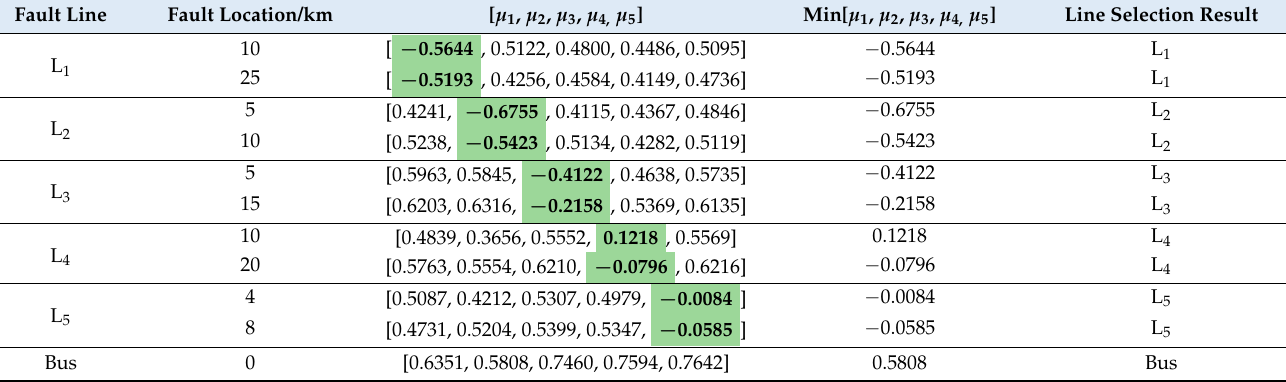
Table 2. The results of feeder identification when R d = 0 Ω and ϕ = π /2.